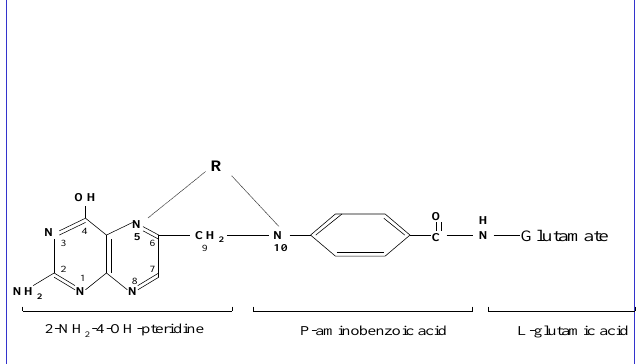
Figure 1. Structural formula of folic acid. This is composed of an unreduced 2-amino-4-hydroxypter- idine molecule linked through methylene (C6-position) to p-aminobenzoylmono-glutamate, while R represents the one-carbon group at different oxidation states in the form of methyl-, methenyl-, methylene-, or formyl-, attached to the N5- and/or N-10 positions as shown in the drawing. The metabolically active form tetrahydrofolate is reduced at the 5,6,7,8 positions of the pteridine ring. Folic acid and folates are a group of interconvertible vitamin B9 forms, which are essential for fertility, embryonic/fetal development and postnatal neurodevelopment, and play multiple roles in intermediary metabolism and epigenetic imprinting, including reg- ulation of gene expression (see Figure 2). It should be noted that vitamin B2, B6 and B12 serve as co-factors for various enzymes interconverting different folate forms, such as the folate dependent homocysteine degradation, the re-methylation cycle, the methionine cy- cle (methionine and SAM production), the transsulfuration cycle and purine and thymi- dylate synthesis. Thus, an adequate pool of these co-factors (vitamin B2, B6, B12) and nor- mal enzyme functioning is required to interconvert different folate forms since each spe- cific folate form participates in the methionine, remethylation and transsulfuration cycles, and thymidine and purine production, resulting in folate dependent cell proliferation, ho- mocysteine catabolism, multiple SAM-mediated methyl-transfer reactions, neurotrans- mitter synthesis and epigenetic mechanisms [2].